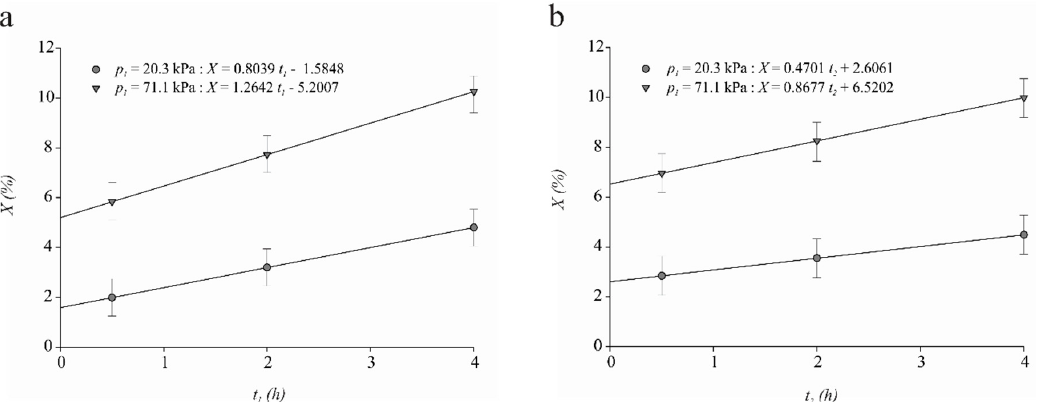
Figure 1. Mean ± Standard error (SE, n = 120) for meat sample volume fraction vacuum impregnated by the isotonic sodium chloride solution ( X ) for both levels of vacuum pressure ( p 1 ) (mean ± SE): ( a ) as a function of the length of the vacuum pressure step ( t 1 ) and, ( b ) as a function of the length of the atmospheric pressure step ( t 2 ).